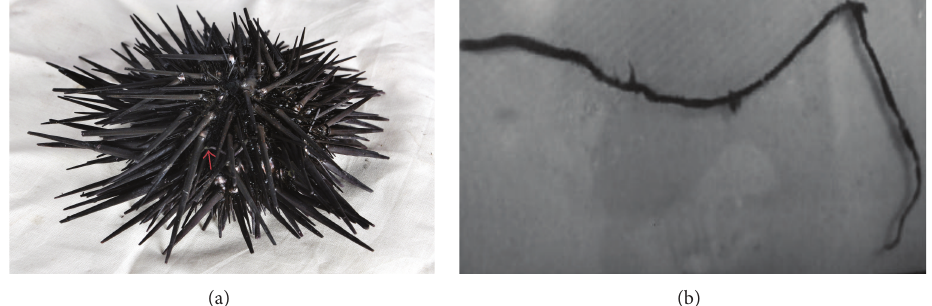
Figure 1: (a) Polychaete associated with Stomopneustes variolaris . (b) Polychaete Lumbrineris latreilli .